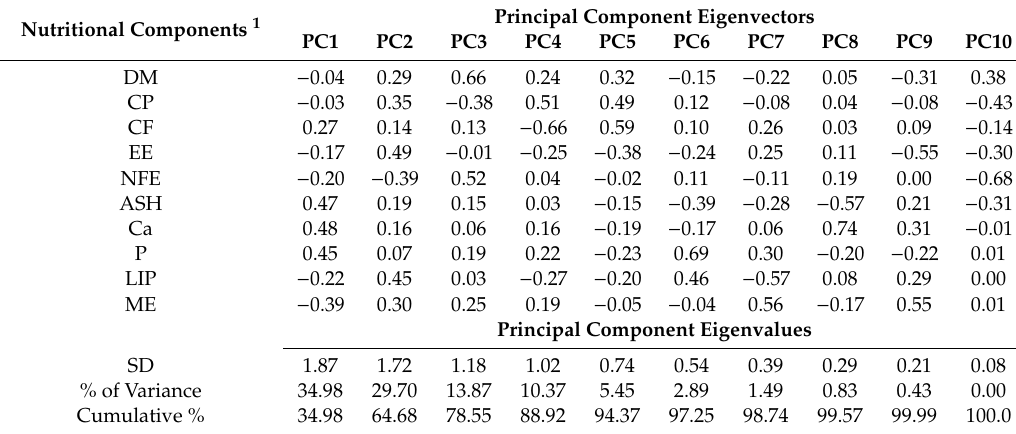
Table 1. Summary table of principal component analysis (PCA), indicating the importance of each nutritional component of diets preferred by kennel cats in food preference tests, standard deviation (SD) and the percentage of explanation of variation linked to each principal component.